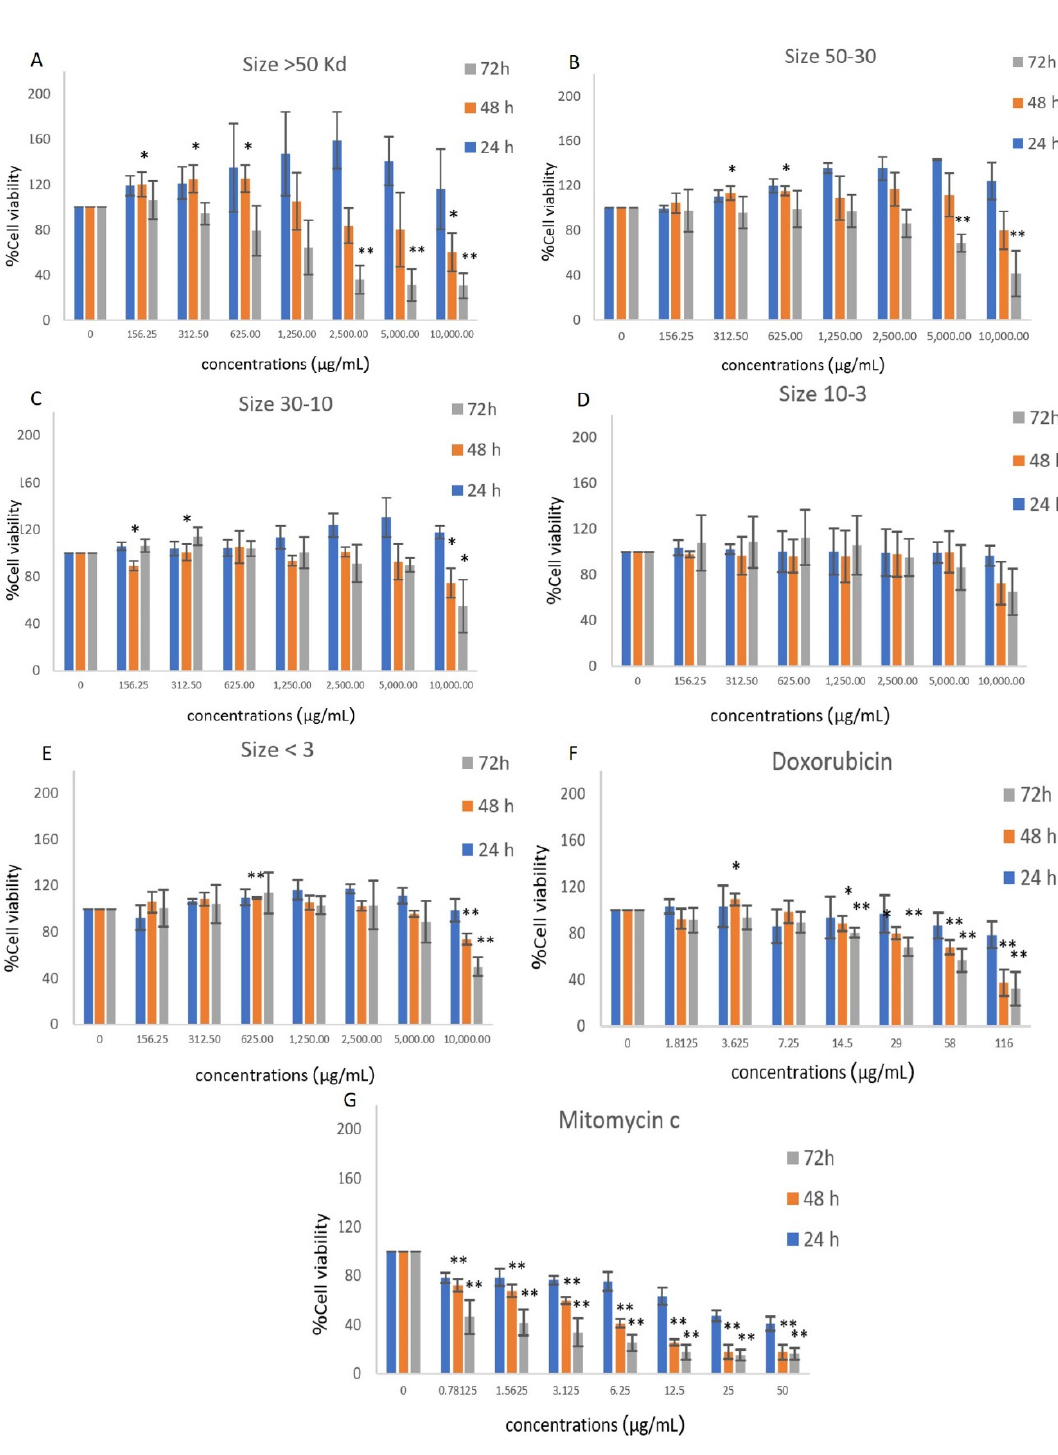
Figure 8. Cytotoxicity test by MTT assay on SW-620 cells after being treated with fractions of HRBE concentrations 0–10,000 µg/mL including ( A ) >50, ( B ) 50–30, ( C ) 30–10, ( D ) 10–3 kDa and ( E ) <3 kDa fractions, ( F ) doxorubicin concentration 0–116 µg/mL and ( G ) mitomycin C concentrations 0–50 µg/mL for 24 h, 48 h and 72 h. The untreated cells (0 mg/mL) were considered as negative control, while the doxorubicin and mitomycin C treatments were considered as the positive control. The percentage of cell viability was determined as compared to an untreated condition. Data are represented by the mean ± SD. Statistical analysis was performed using student’s t -test (*, p ≤ 0.05 significant; **, p ≤ 0.01 significant).